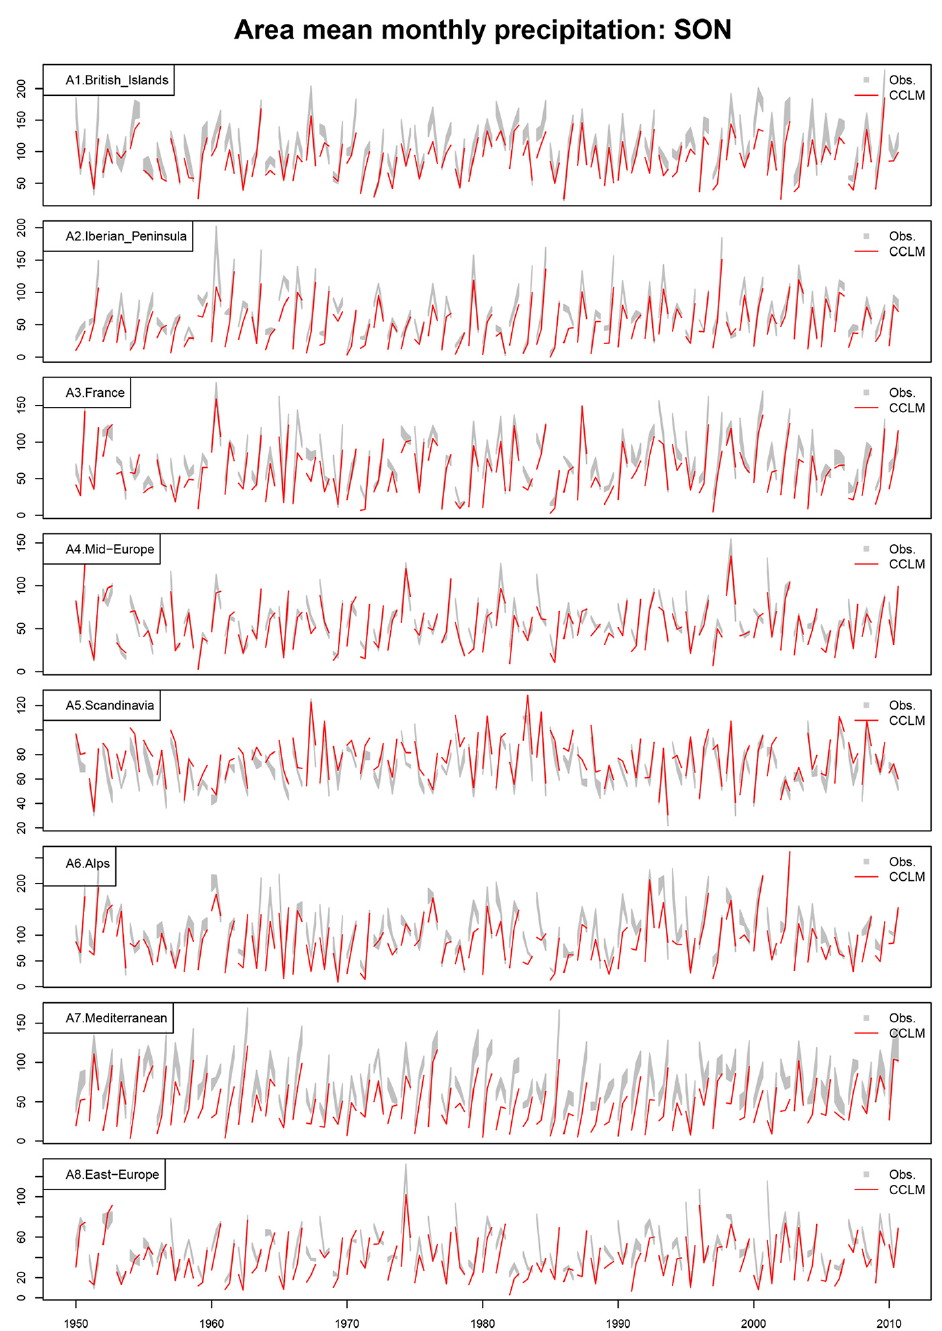
Figure 8d. Area mean monthly sums of total precipitation of September, October, and November of 1950–2010: coastDat2-CCLM (red), range of GPCC6, E-OBS8.0 and CRU3.2 for each season (gray